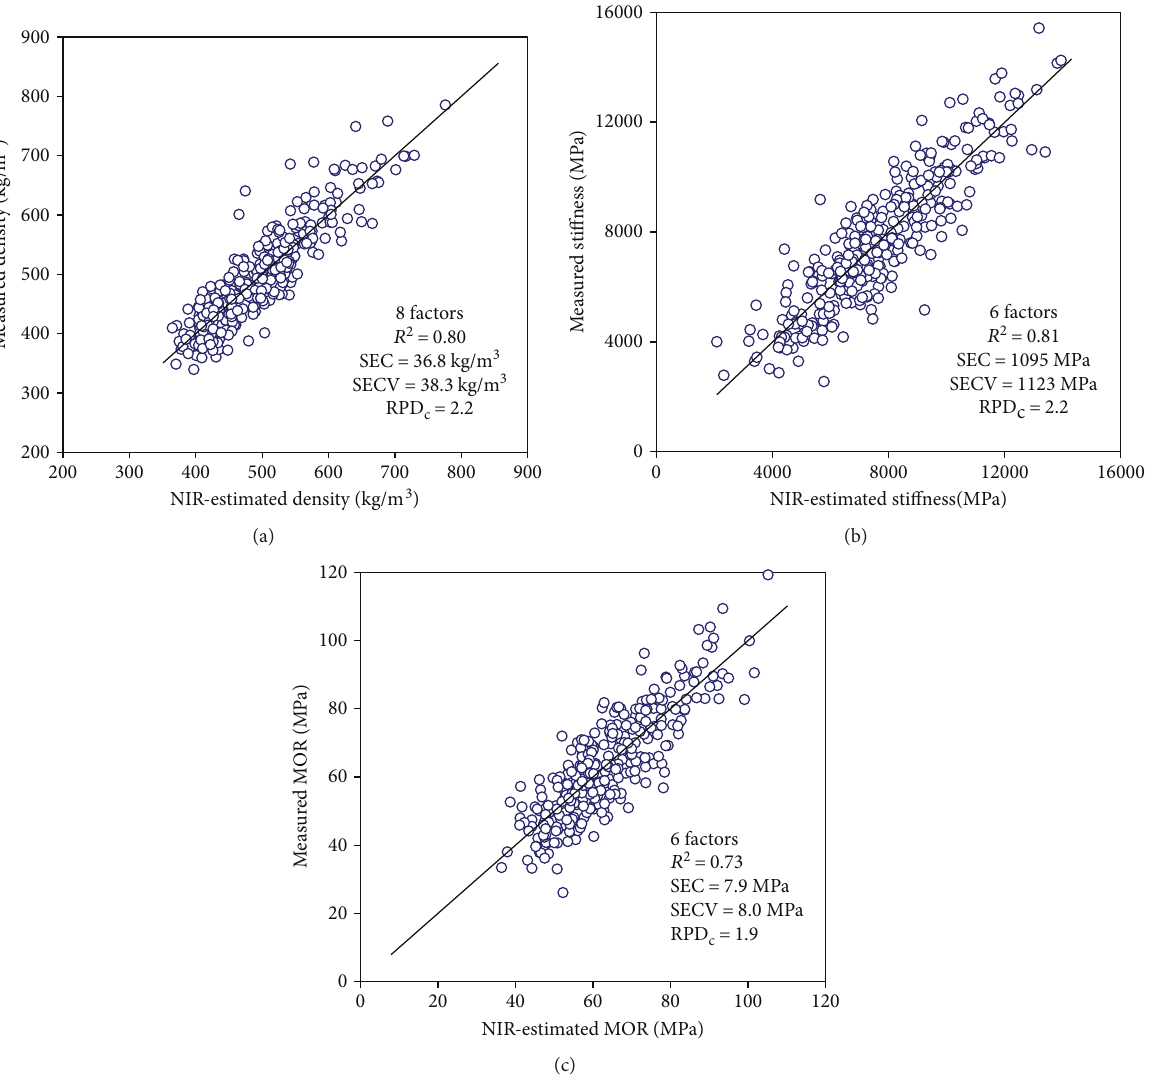
Figure 4: Relationship between lab-measured wood properties and NIR- fi tted wood properties, (a) density, (b) modulus of elasticity (MOE), and (c) modulus of rupture (MOR). The broken line represents the line of equivalence. 332 samples were used to develop the density calibration, while 334 samples were used to develop the calibrations for MOE and